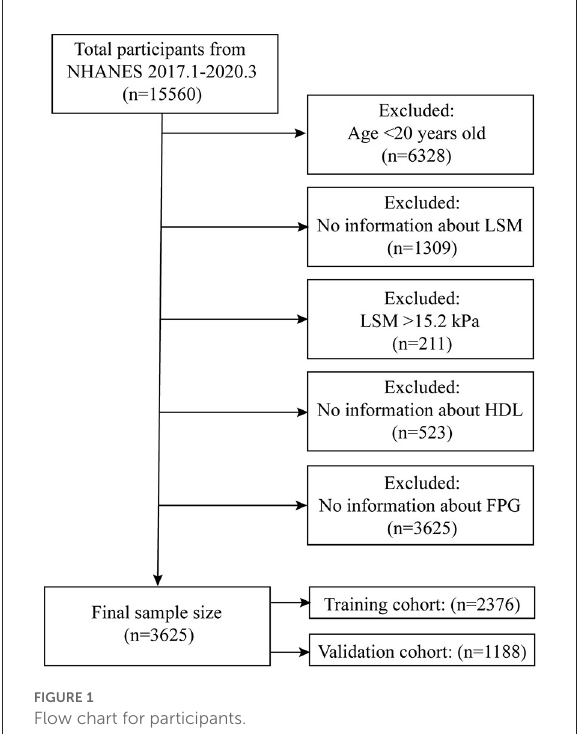
FIGURE1 Flow chart for participants.